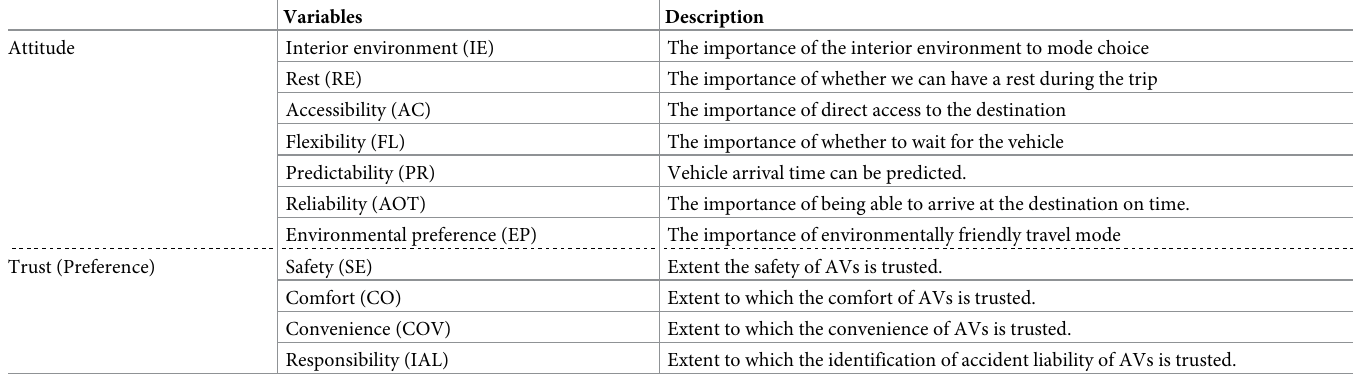
Table 1. Description of attitudes and preference